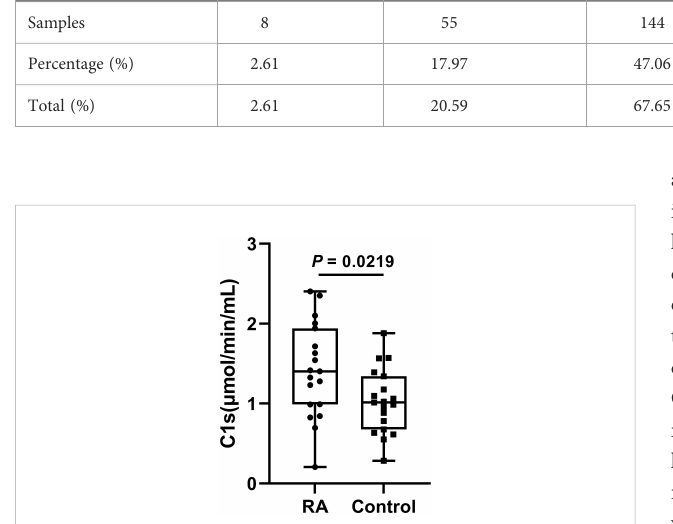
FIGURE 6 The levels of active C1s in serum of patients with RA. Data are presented as the means ± standard deviation (each group: n = 20). P = 0.0219 by t